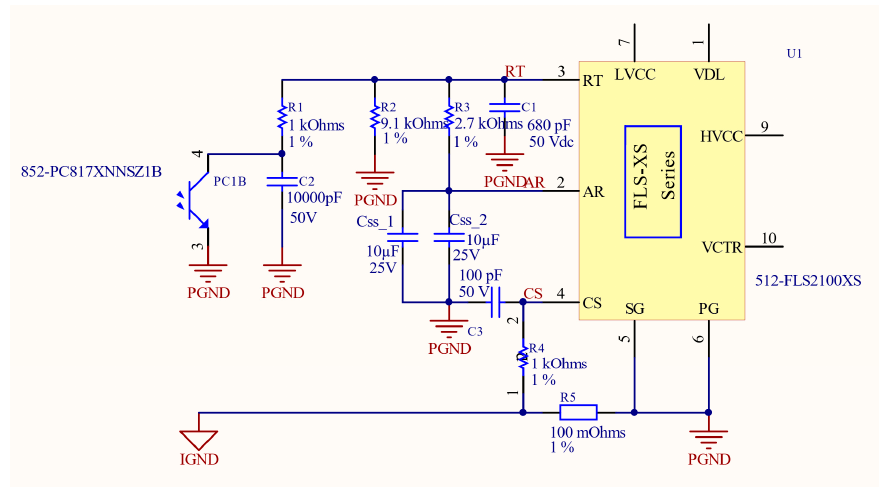
Figure 12. Typical circuit configuration for RT pin of IC FLS2100XS.